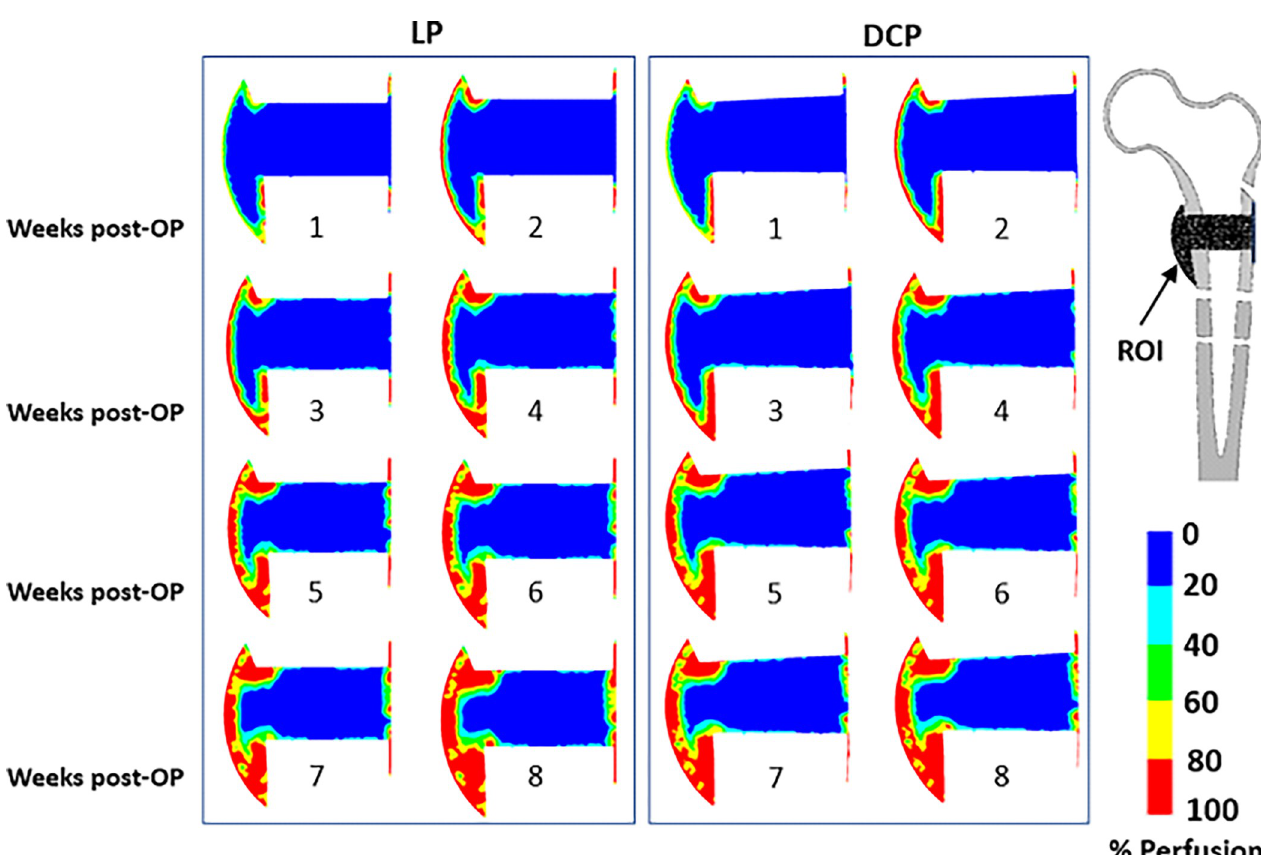
Fig 5. Post-operative distribution of percentage blood perfusion in the ROI from week 1–8 for (a) LP and (b) DCP.